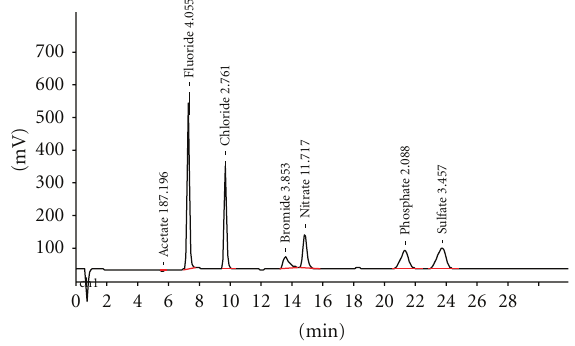
Figure 13: IC output for multi-standard solution. The con- centration of the di ff erent ions can be obtained from the ion